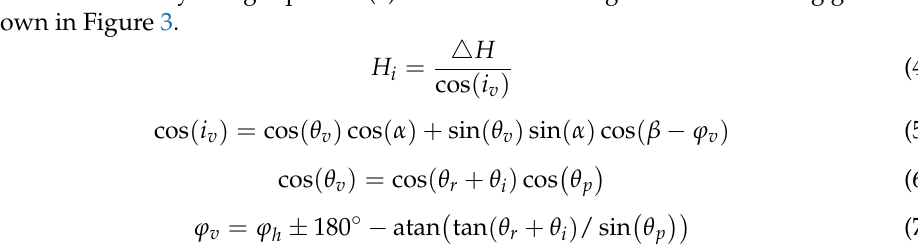
where m is the number of rows, E ij ( λ ) is the radiance of row j in column i, H ij is the radiation transmission path of row j in column i, E ⊥ j ( λ ) is the radiance of row j in the scanning center point, and H ⊥ j is the radiation transmission path of row j in the scanning center